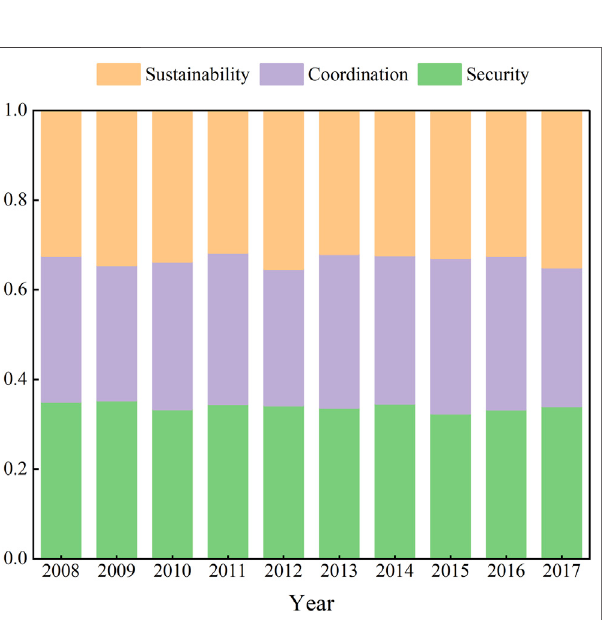
FIGURE 4 | Proportional sub-criteria rated in Sichuan province from 2008 to